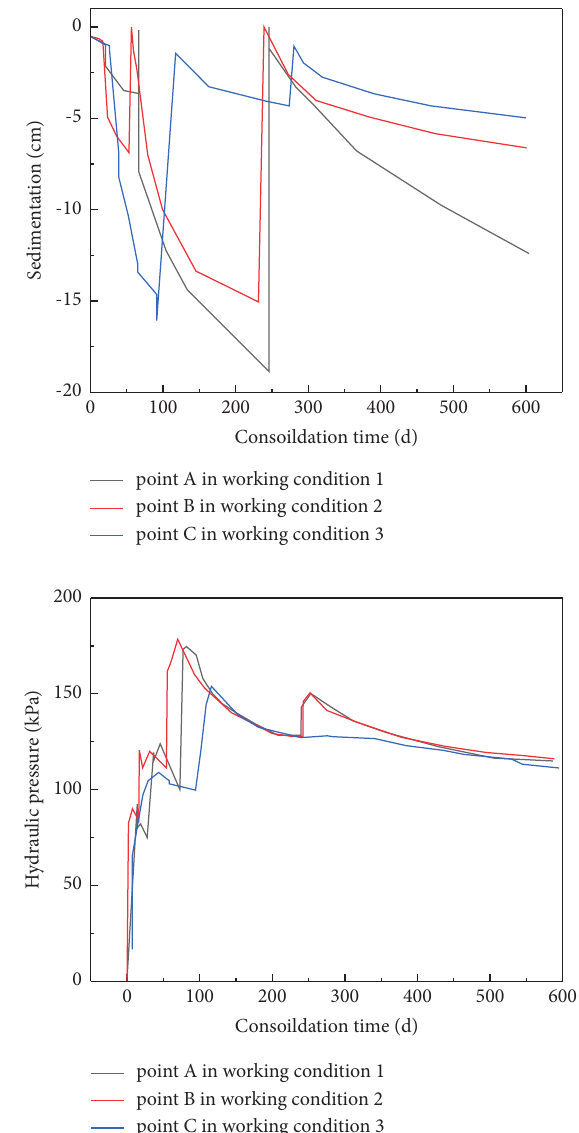
Figure 3: Settlement curve and water pressure curve at the middle point of foundation under different working